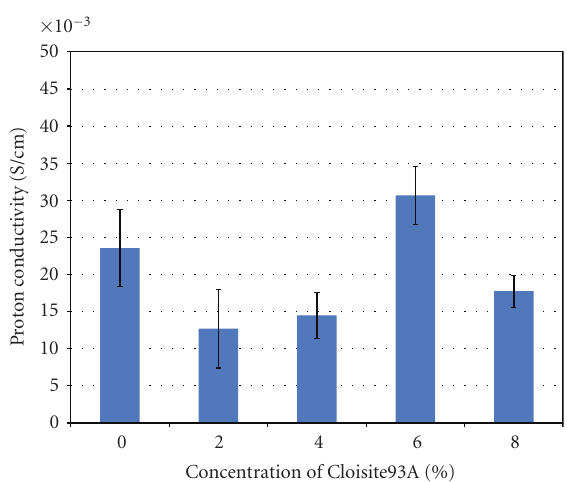
Figure 7: C/P ratios of sulfonated PVA membranes with varying concentrations of Cloisite